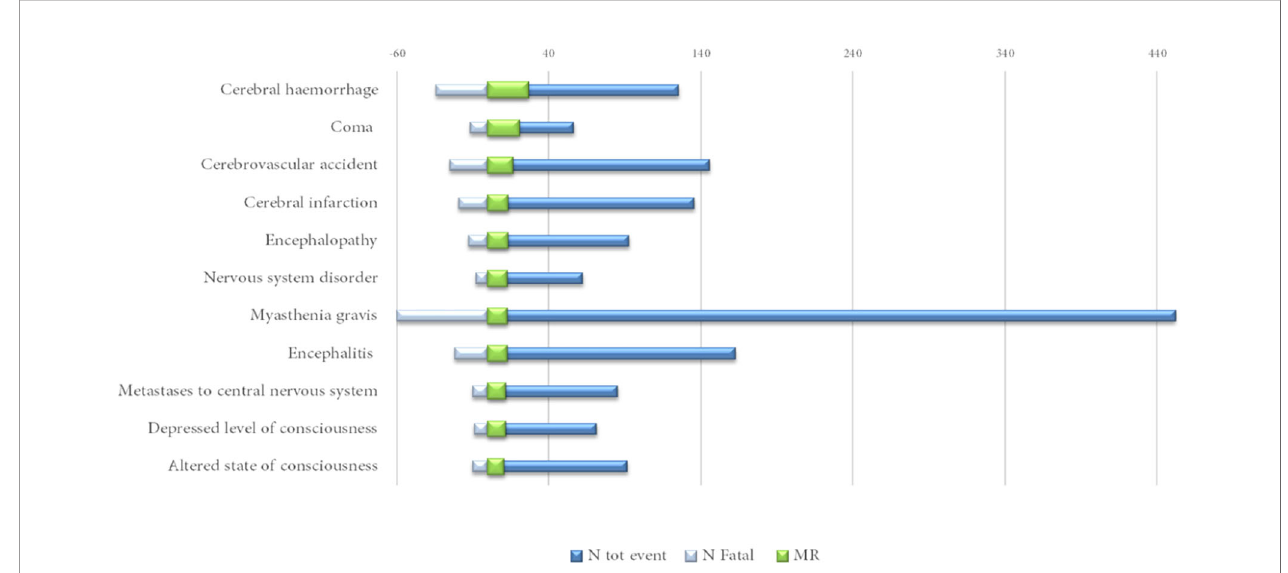
FIGURE 4 | Neurological complications reported in at least 40 cases with a mortality rate (MR) above